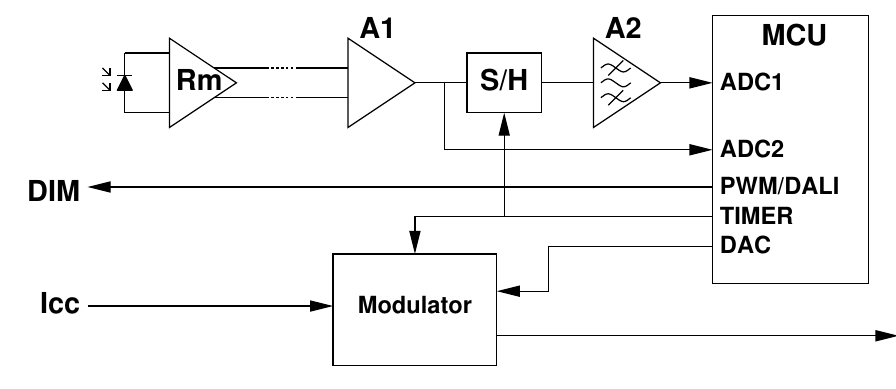
Figure 4. Control and sensing